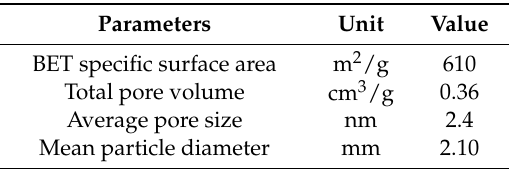
Table 1. Basic physical properties of fine-pore silica